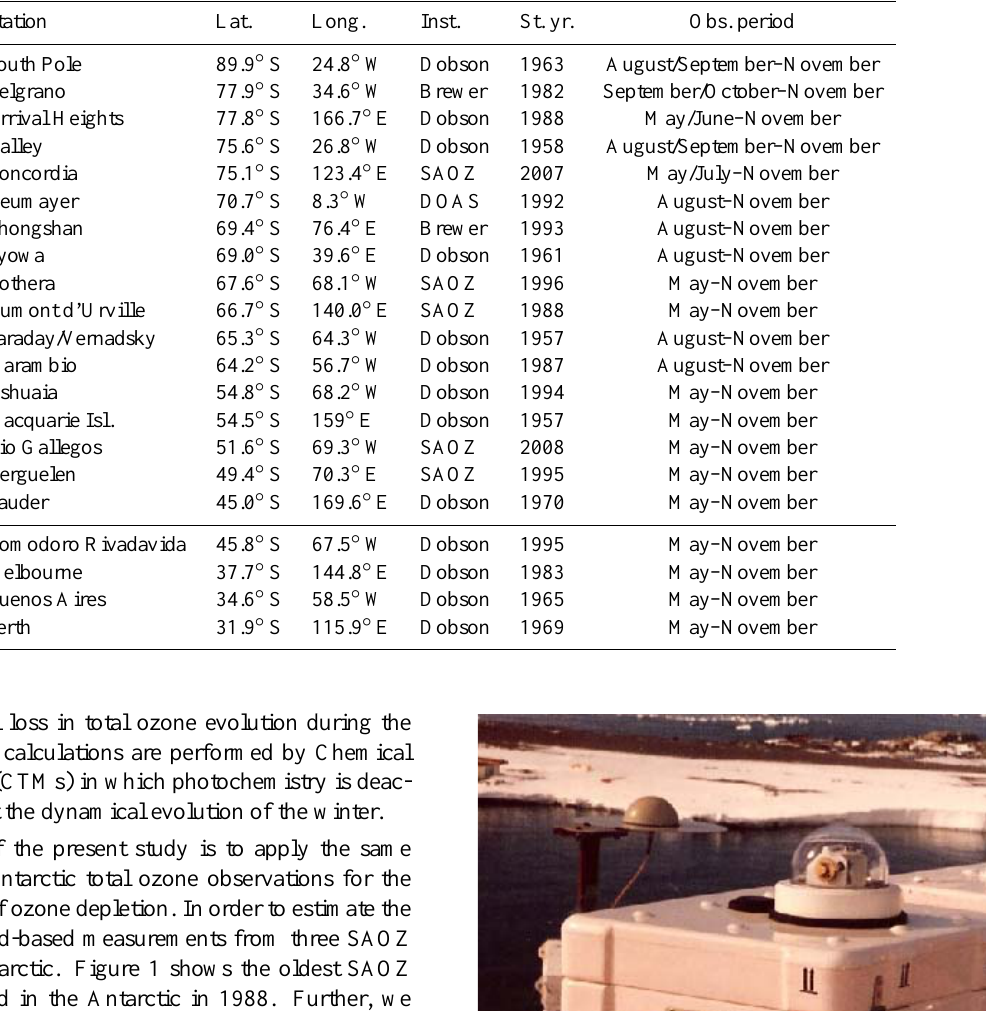
Table 1. Measurement station, latitude (Lat.), longitude (Long.), type of observation (Inst.), starting year of observation (St. yr.), and period of wintertime measurements (Obs. period) for which the ozone loss analyses are performed. The mid-latitude stations followed by the horizontal line are not considered for ozone loss analyses, but are used for the diagnosis of inter-annual variations in total ozone in the mid-latitudes.